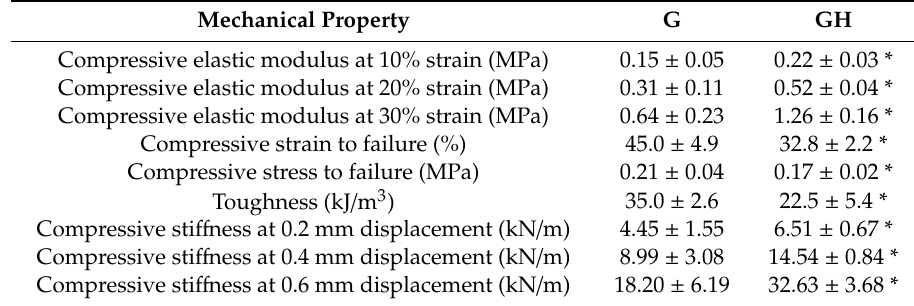
Figure 3. The typical compressive stress–stain curves of the G and GH cryogels. The lines are fitted curves from Equation (5). Table 1. Mechanical properties of G and GH cryogels. Values are the mean ± standard deviation (SD) of five independent measurements.